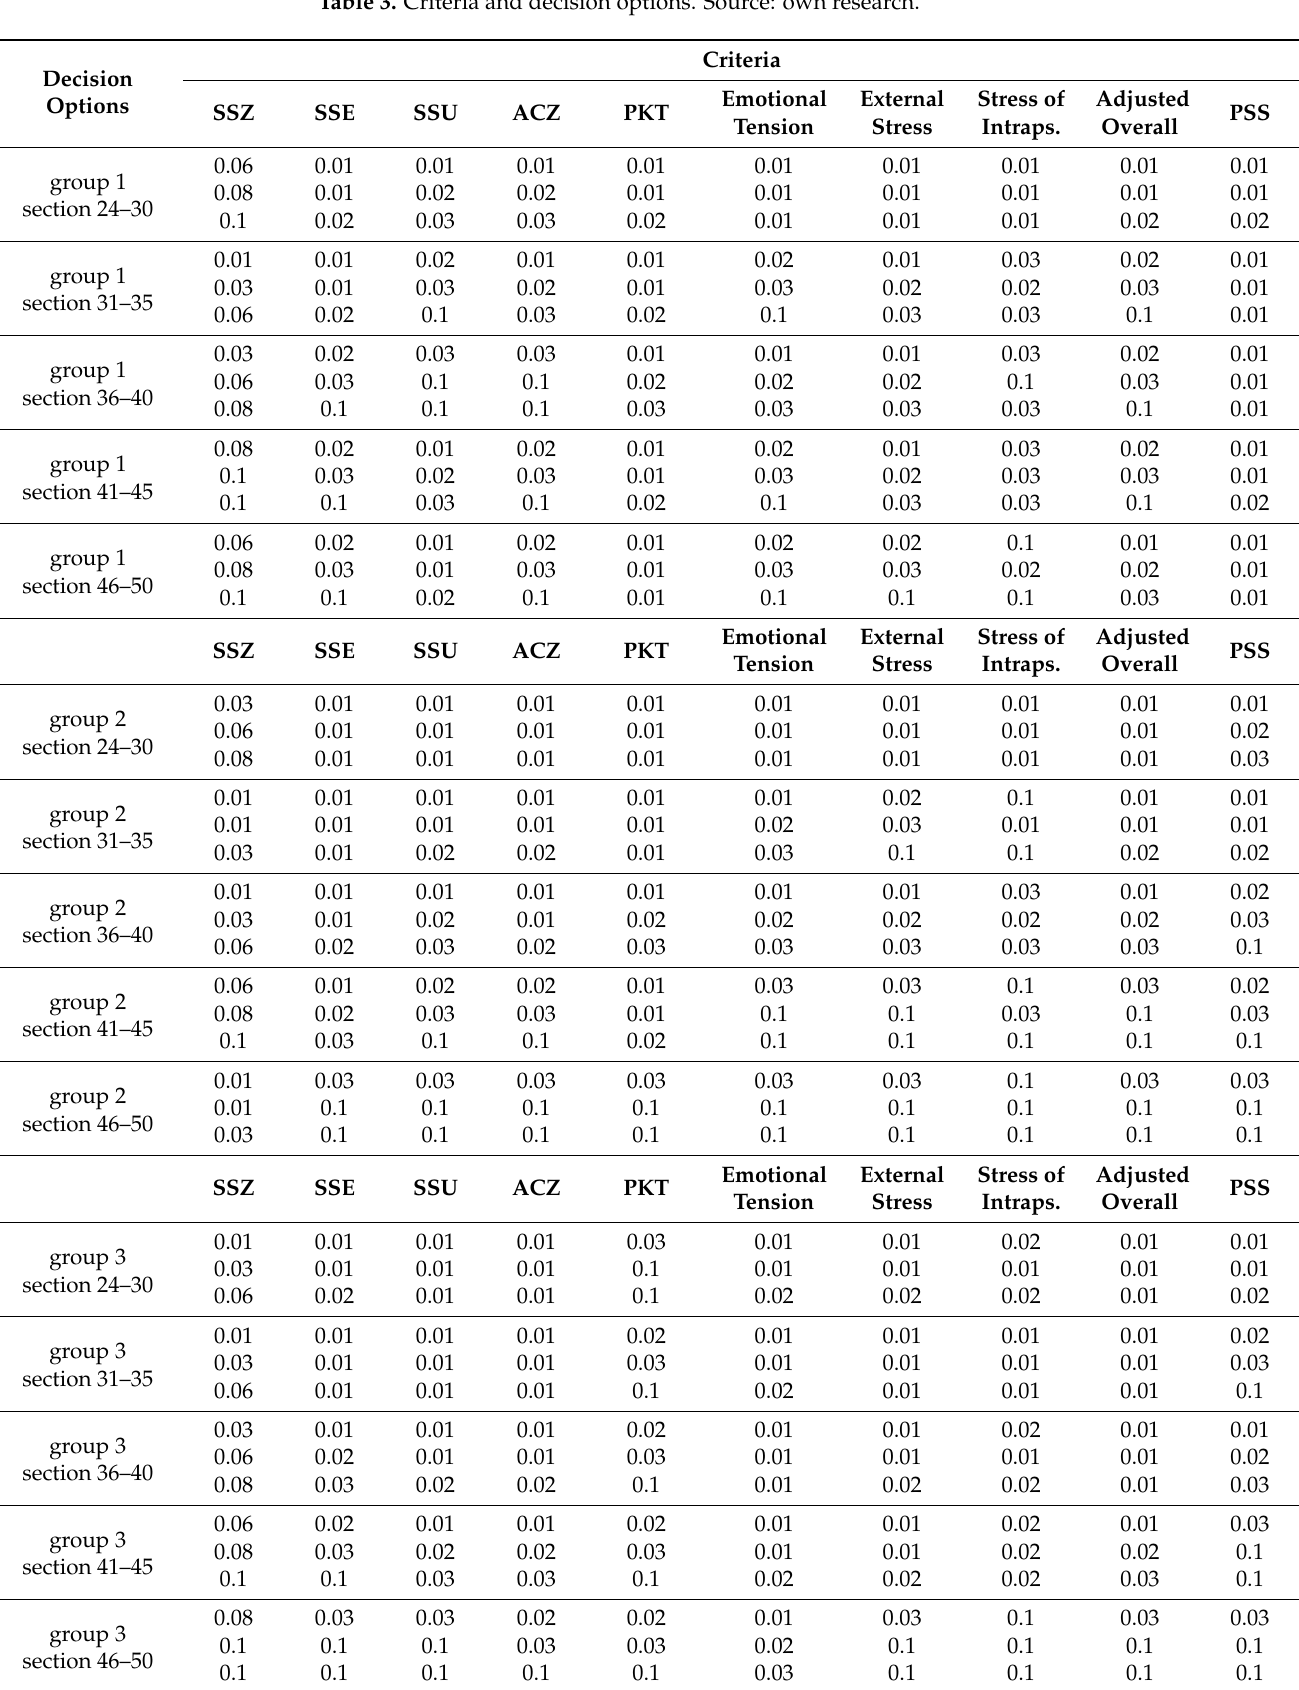
Table 3. Criteria and decision options. Source: own